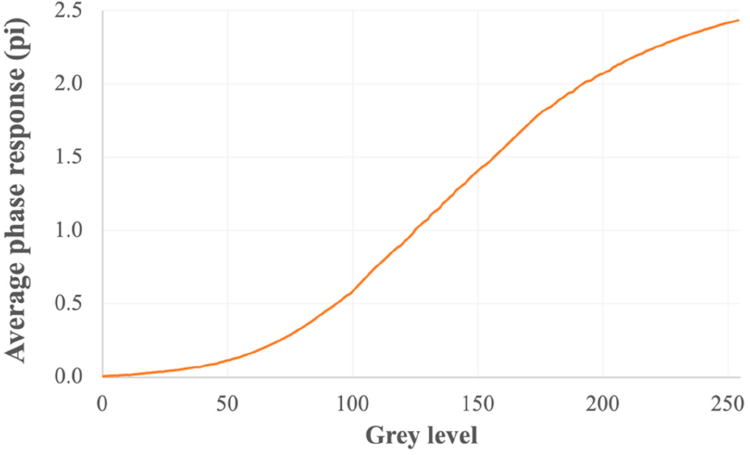
Figure 7. The calculated phase response of the LCOS device based on the experimental results.